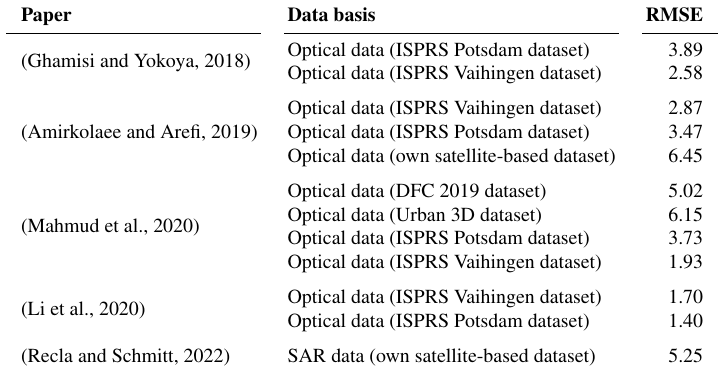
Table 3. Reconstruction quality metrics achieved in related work. For sake of comparability, only the best RMSE value achieved by training and testing on the same scene is reported for each work. Results of transferability were not considered where available at all.